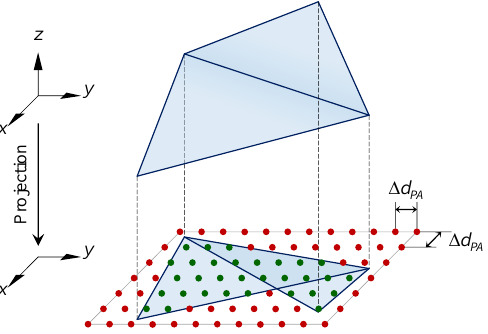
Figure 8. Principle of projected leaf area measurement. The points inside and outside the projected triangles are in green and red, respectively.